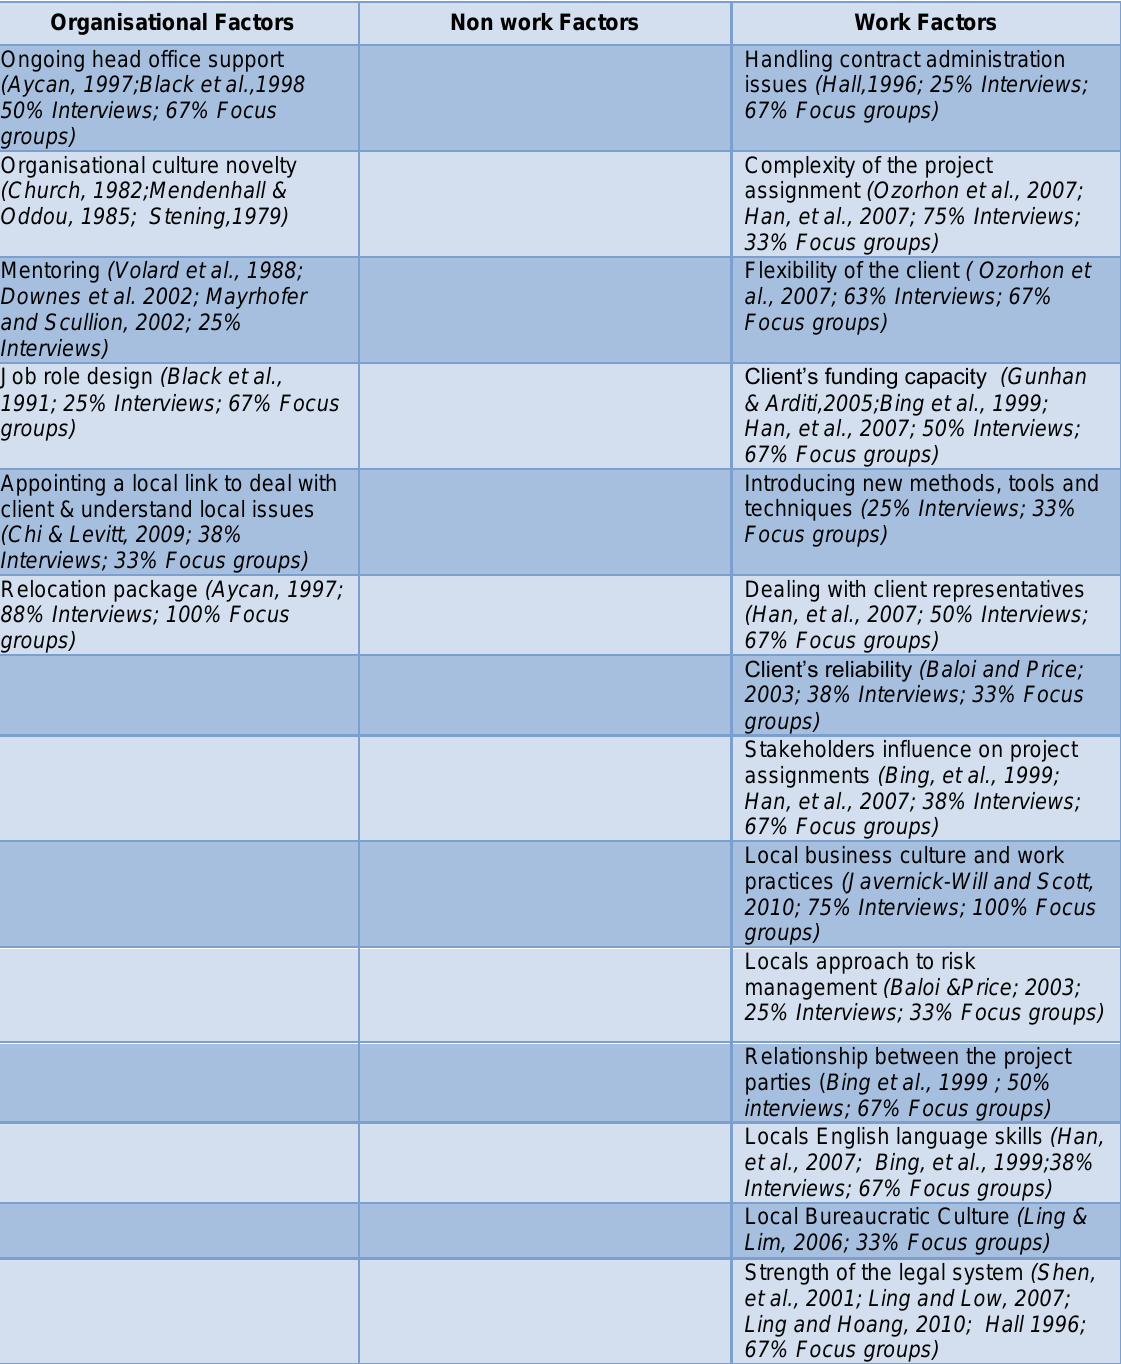
Table 2 Factors extracted from Literature Review, Interviews and Focus Groups